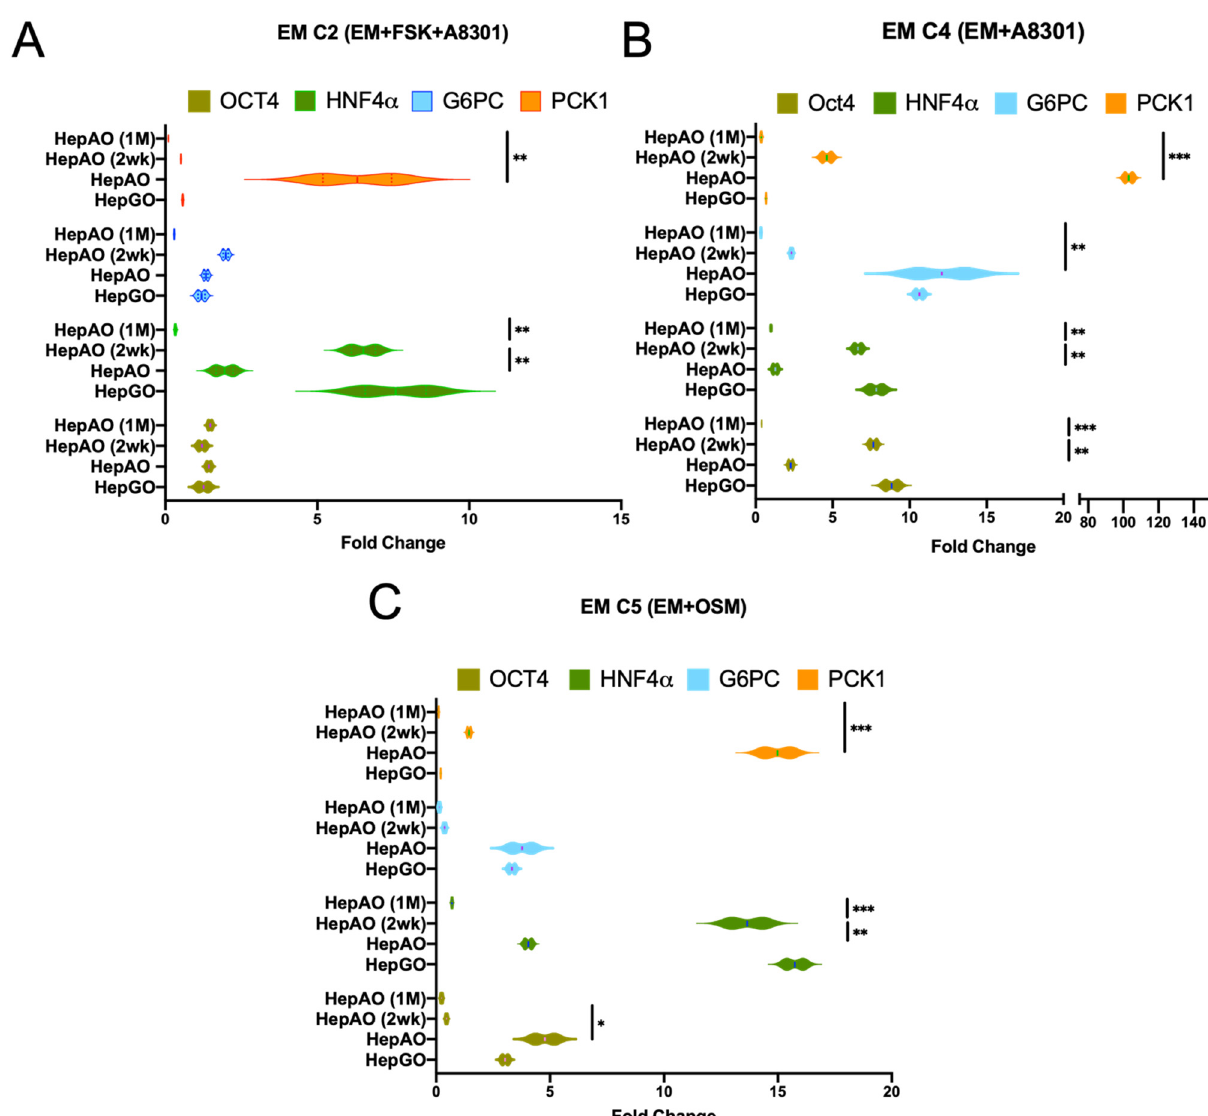
Figure 4. Expansion and freezing of human hepatic organoids in 3D culture. ( A – C ) Expression of OCT4 (surrogate marker for ASC), hepatic marker HNF4 α , and gluconeogenic markers G6PC and PCK1 in HepGOs, HepAOs (immediately after EM), and HepAOs after 2-week (HepAO-2wk) or one month (HepAOs-1M) of organoid freezing and thawing under various EM conditions with FSK + A8301, A8301, and OSM (C3–C5). Data demonstrate the normalized fold change over base line expression in organoid cultures. Data are from experiments that were performed in at least in duplicate with (N = 3) donor hepatocytes and multiple HepG2 organoid cultures, each in three replicates per condition. (*** p < 0.001, ** p < 0.01, * p < 0.05).